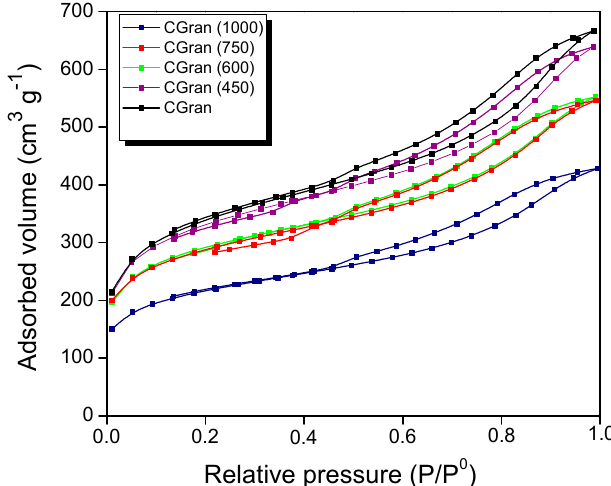
Figure 3. N 2 adsorption-desorption isotherms at 77 K of CGran and CGran(x) activated carbon supports.